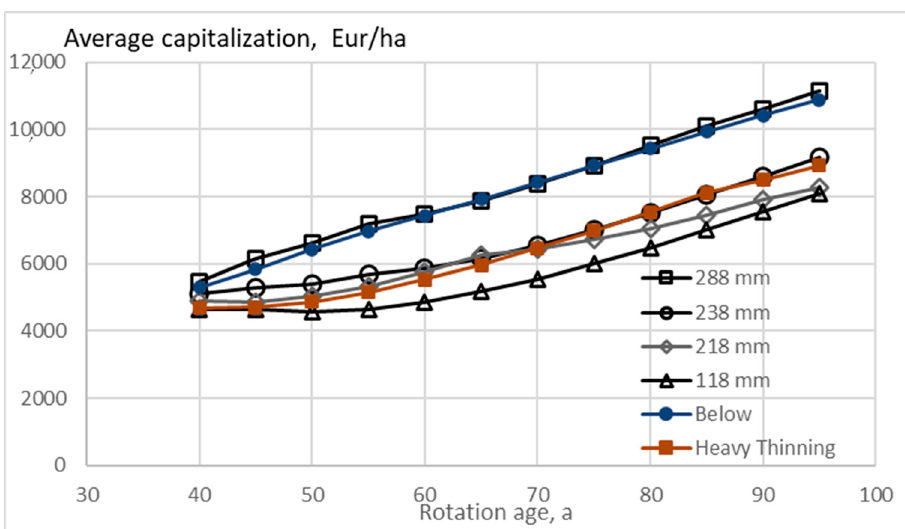
Figure 7. The expected value of capitalization for six different treatment schedules applied on a normal stand representing the example estate. The capitalization is integrated over stand age until any rotation age.